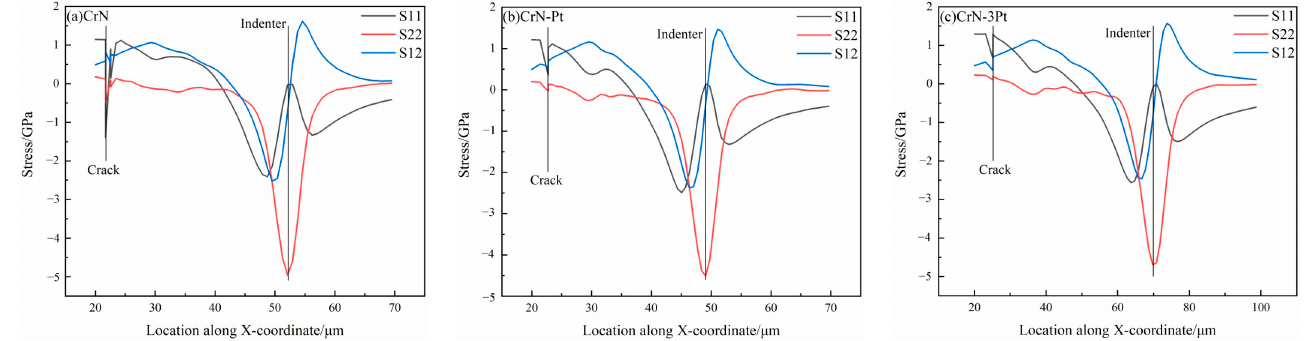
Figure 11. Anisotropic stress distribution in the middle of the three coating cracks when the crack propagates to the bonding surface of the film base. ( a ) CrN; ( b ) CrN-Pt; ( c ) CrN-3Pt.